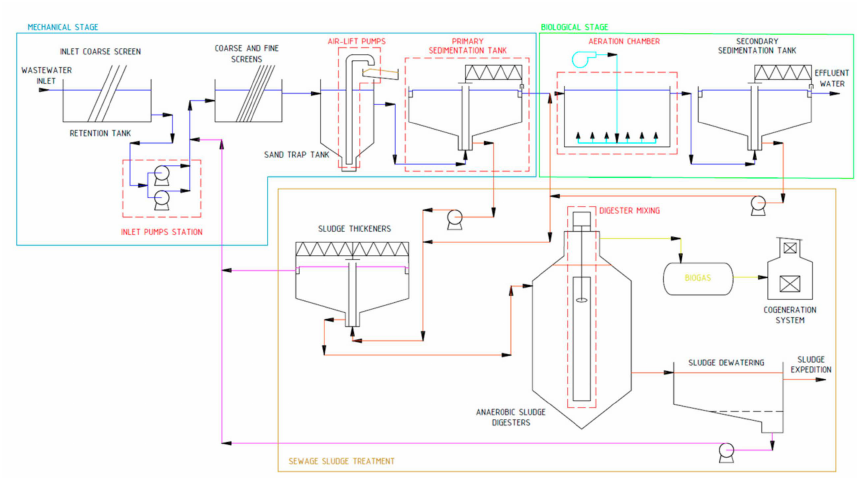
Figure 1. Block diagram of wastewater treatment plants with the analyzed technologies highlighted. Modified from Reference